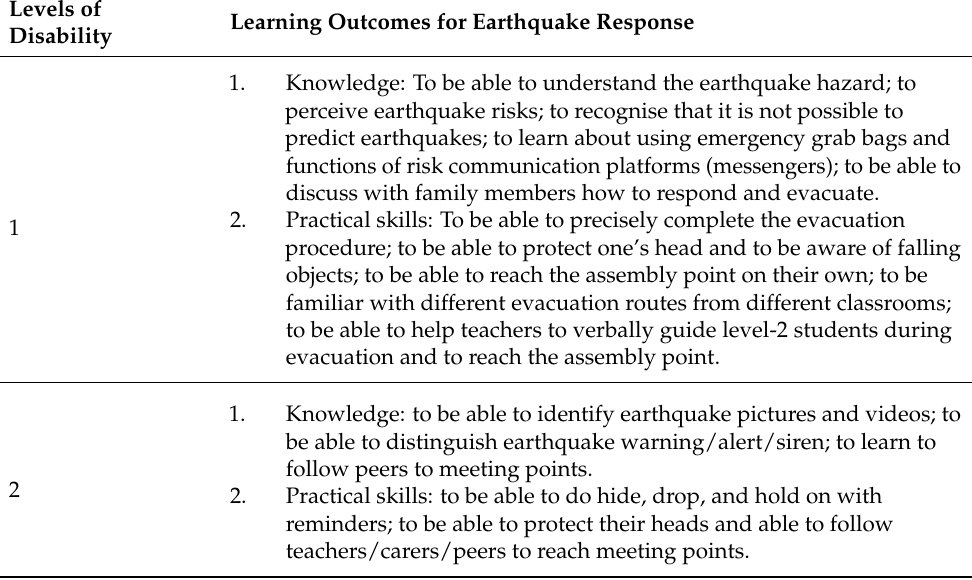
Table 3. Learning outcomes for students with different levels of disabilities. Levels